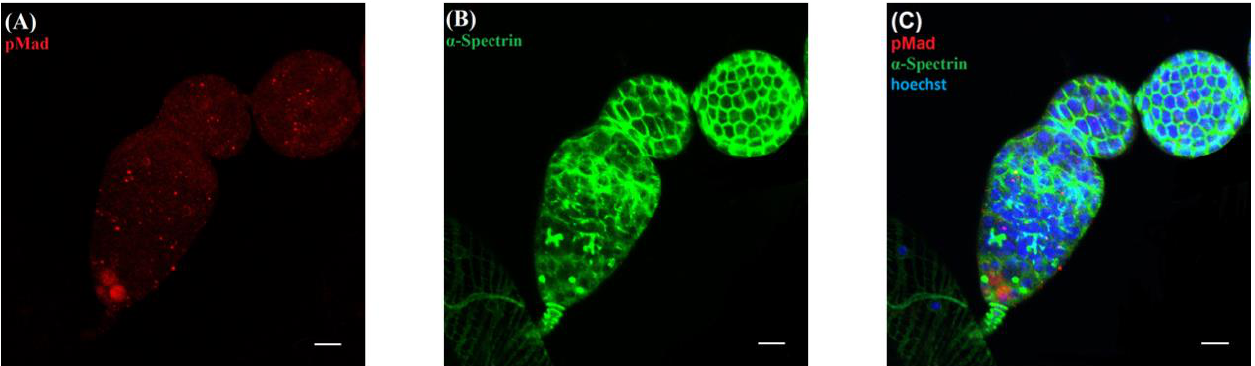
antibody (Figure 2).